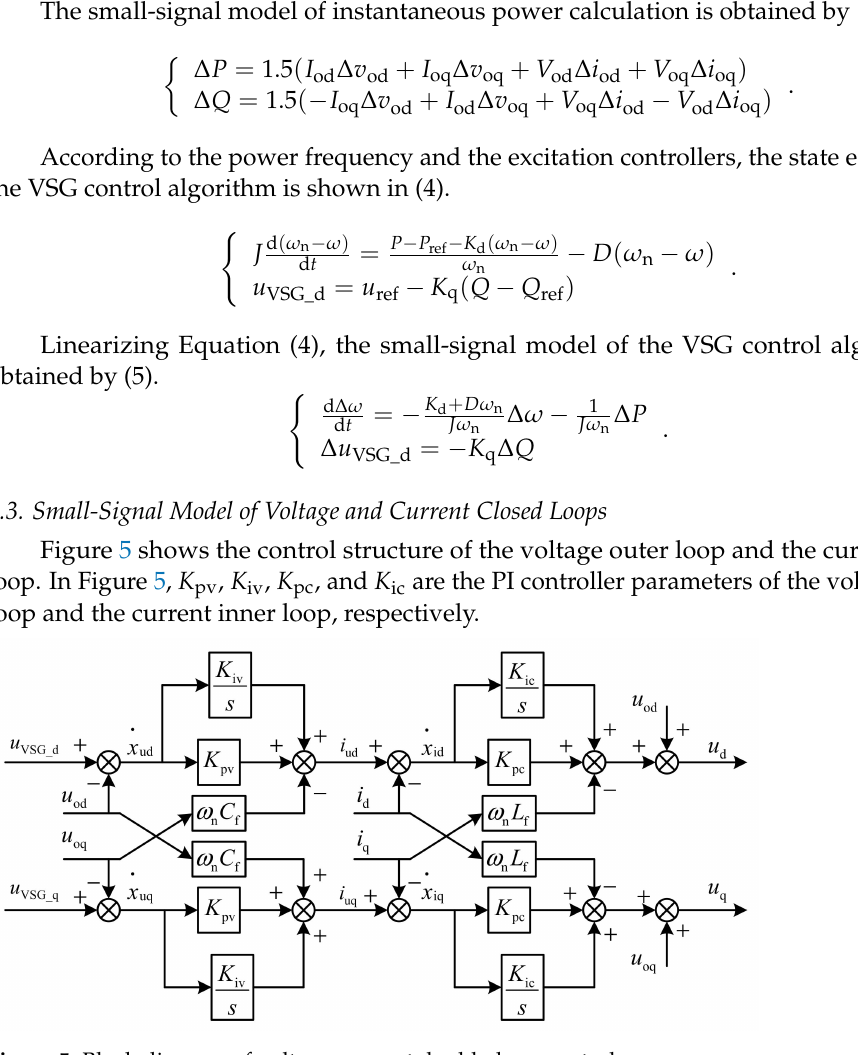
Figure 5. Block diagram of voltage–current double-loop